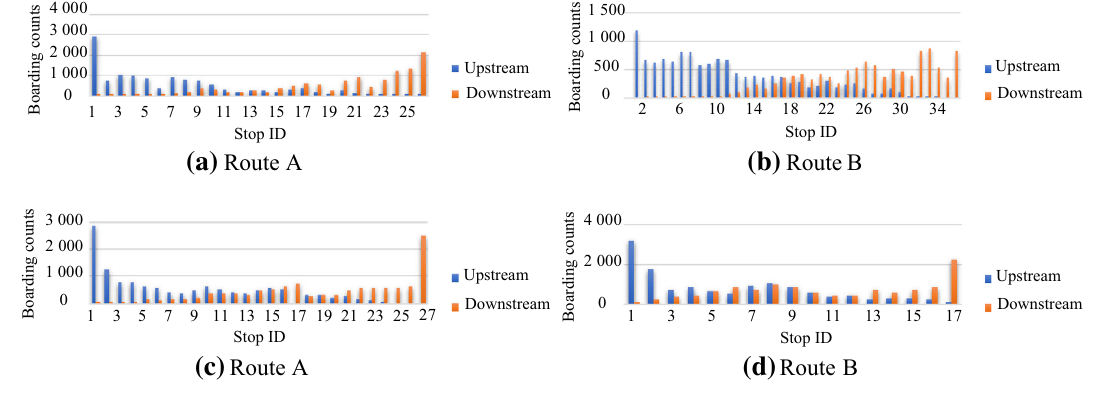
Fig. 5 Boarding counts at